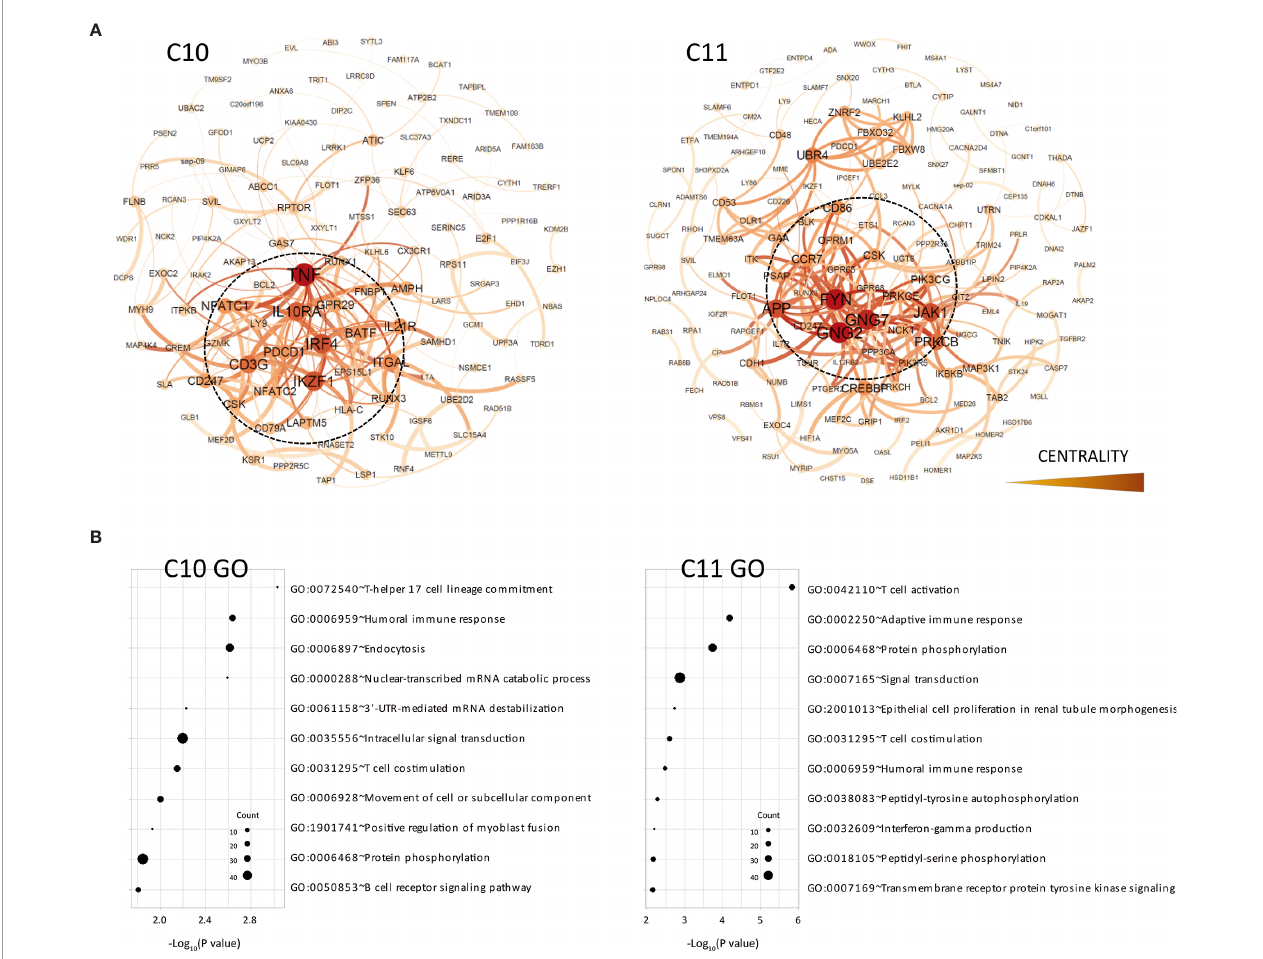
FIGURE 2 | Functional analysis of clusters C10 and C11. (A) Functional interaction networks derived from co-methylated clusters (C10 and C11) obtained from WGCNA analysis, corresponding to DMRs hypomethylated in the TOL group. Network centrality is indicated by the color scale and node size. (B) Gene ontology analysis of clusters C10 and